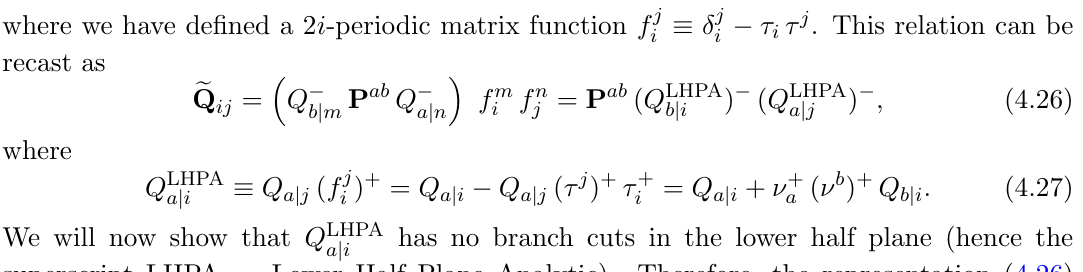
Figure 4 . Gluing the two analyticity regions from the sheets 1 and 2 of (cid:12)gure 3, one de(cid:12)nes the mirror sheet, with a single long